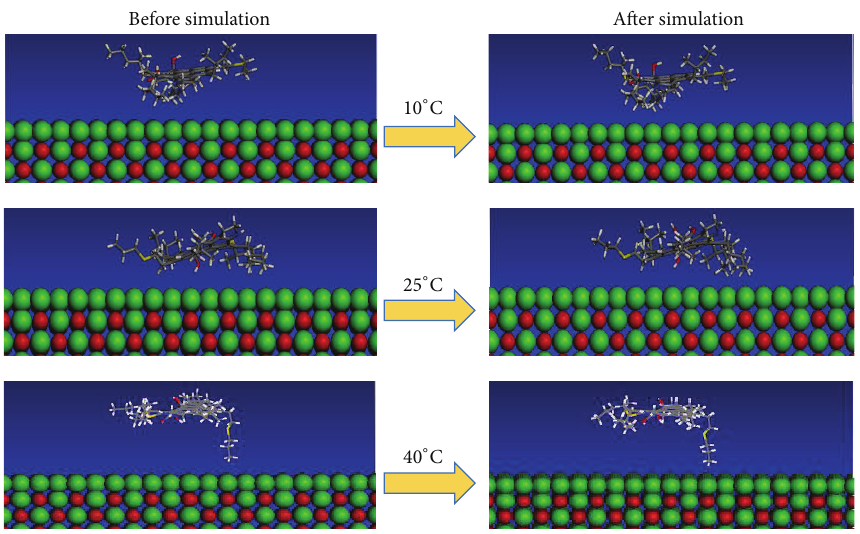
Figure 10: The interface configuration of asphaltene/CaO (10–40 ∘